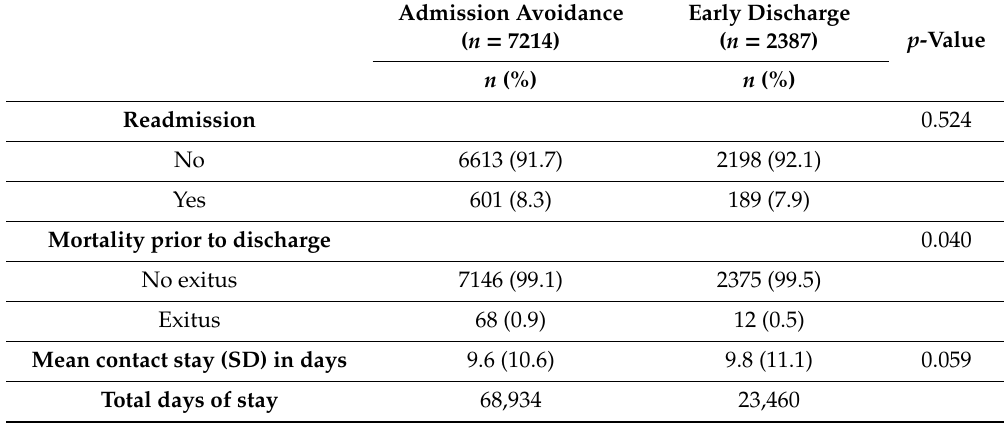
Table 2. Readmission, mortality, and mean length of stay according to the hospital-at-home modality. Admission